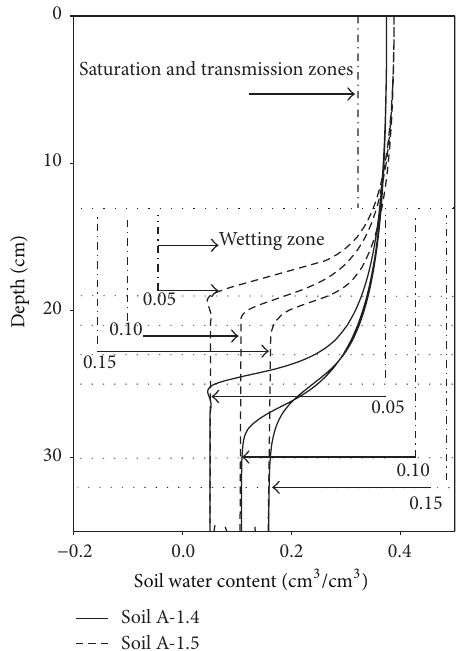
Figure 10: Simulated soil water content profiles after 30 min of infiltration in columns of Soil A with two different bulk densities (1.4 or 1.5 g/cm 3 ) for different initial soil water contents (0.05, 0.10, and 0.15cm 3 /cm 3 ) and a ponding depth of 2.5